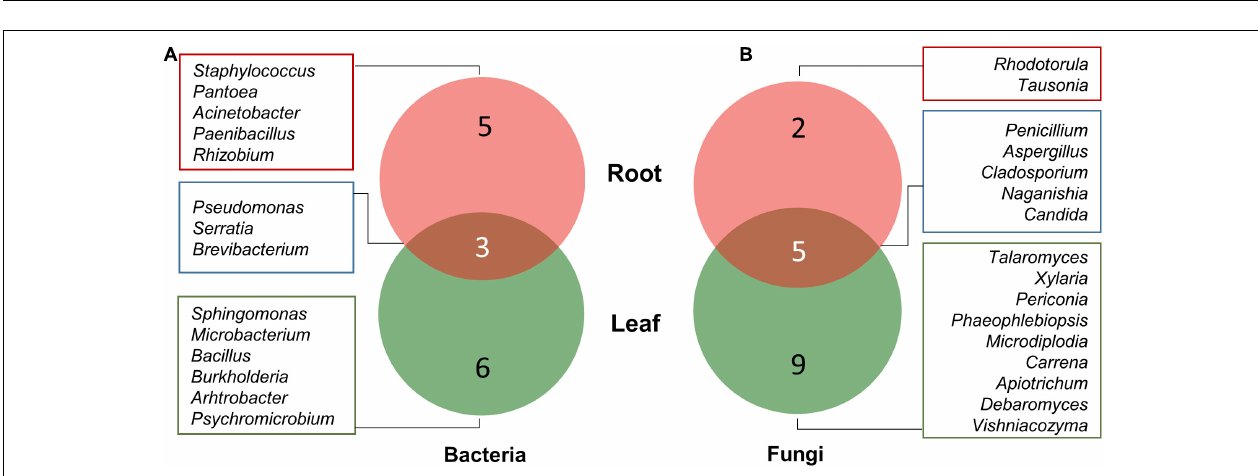
FIGURE 2 | Phylogenetic relation among fungal endophytes isolated from A. euchroma leaf and root tissues. A total of 33 fungi were isolated and analyzed for reconstruction of phylogeny using the Maximum Likelihood method with bootstrap replication of 1,000. A reoccurrence frequency of ≥ 50% is indicated on the node by a circle. A solid circle and triangle before taxonomic designation indicate root and leaf endophyte, respectively.